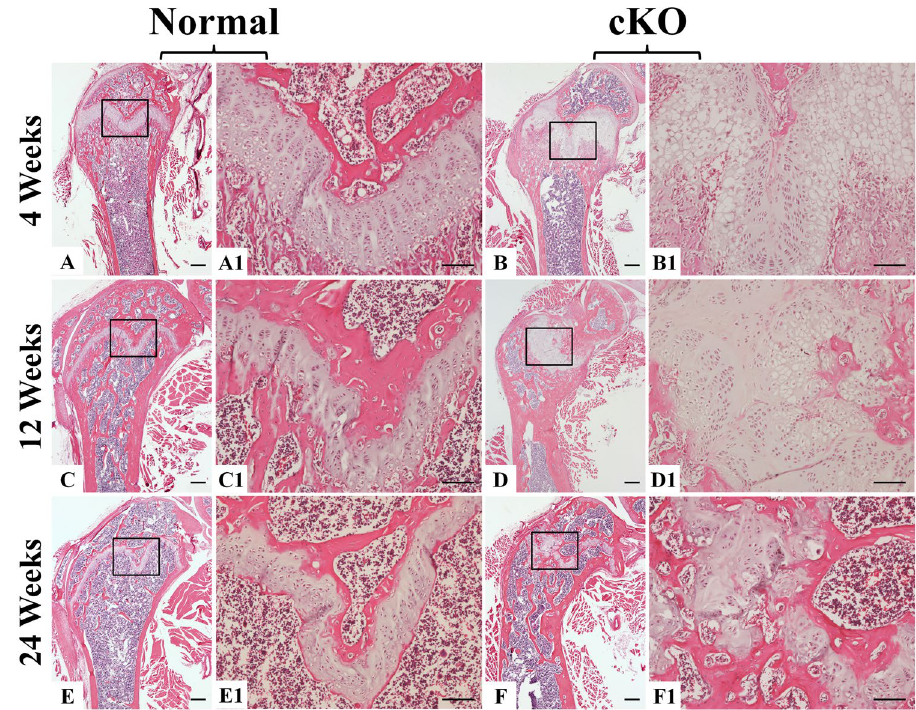
Figure 3. H&E staining of femurs from 4-, 12- and 24-week-old mice. At postnatal 4 and 12 weeks, the growth plates in the cKO mice were much wider than in the normal mice; different segments of the growth plates in the cKO mice showed great variations in thickness. ( A , A1 , B , B1 , C , C1 , D , D1 ). In particular, the hypertrophic zone of growth plate in the 4-week-old cKO mice appeared dramatically enlarged ( B , B1 ). At postnatal 24 weeks, the growth plate in the cKO mice was disorganized compared to the normal mice ( E , E1 , F , F1 ). ( A1 , B1 , C1 , D1 , E1 and F1 ) were the higher magnification views of the box areas in ( A , B , C , D , E and F ) respectively. Bars in ( A , B , C , D , E and F ) 500 µ m; bars in ( A1 , B1 , C1 , D1 , E1 and F1 ) 100 µ